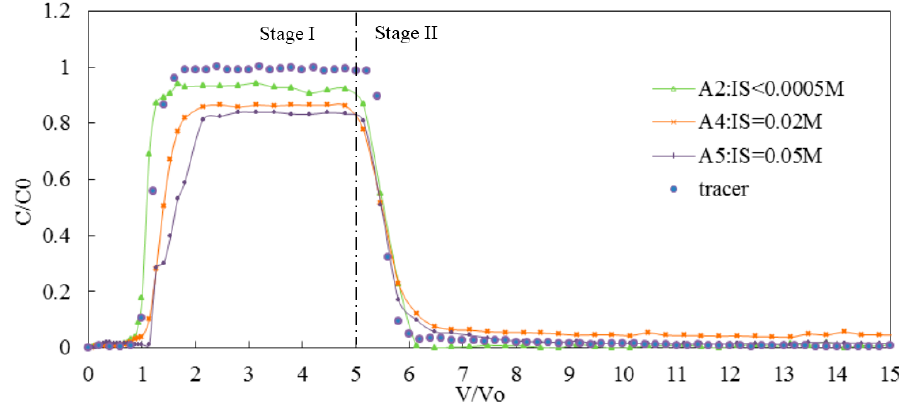
Figure 4. Breakthrough curves of silica colloid under various concentrations of NaCl.